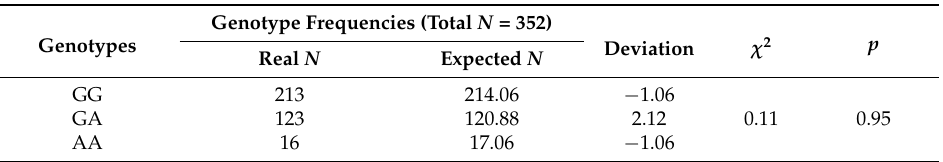
Table 2. LOX G473A genotype frequency analysis for control group by Hardy-Weinberg Equilibrium (HWE) test.